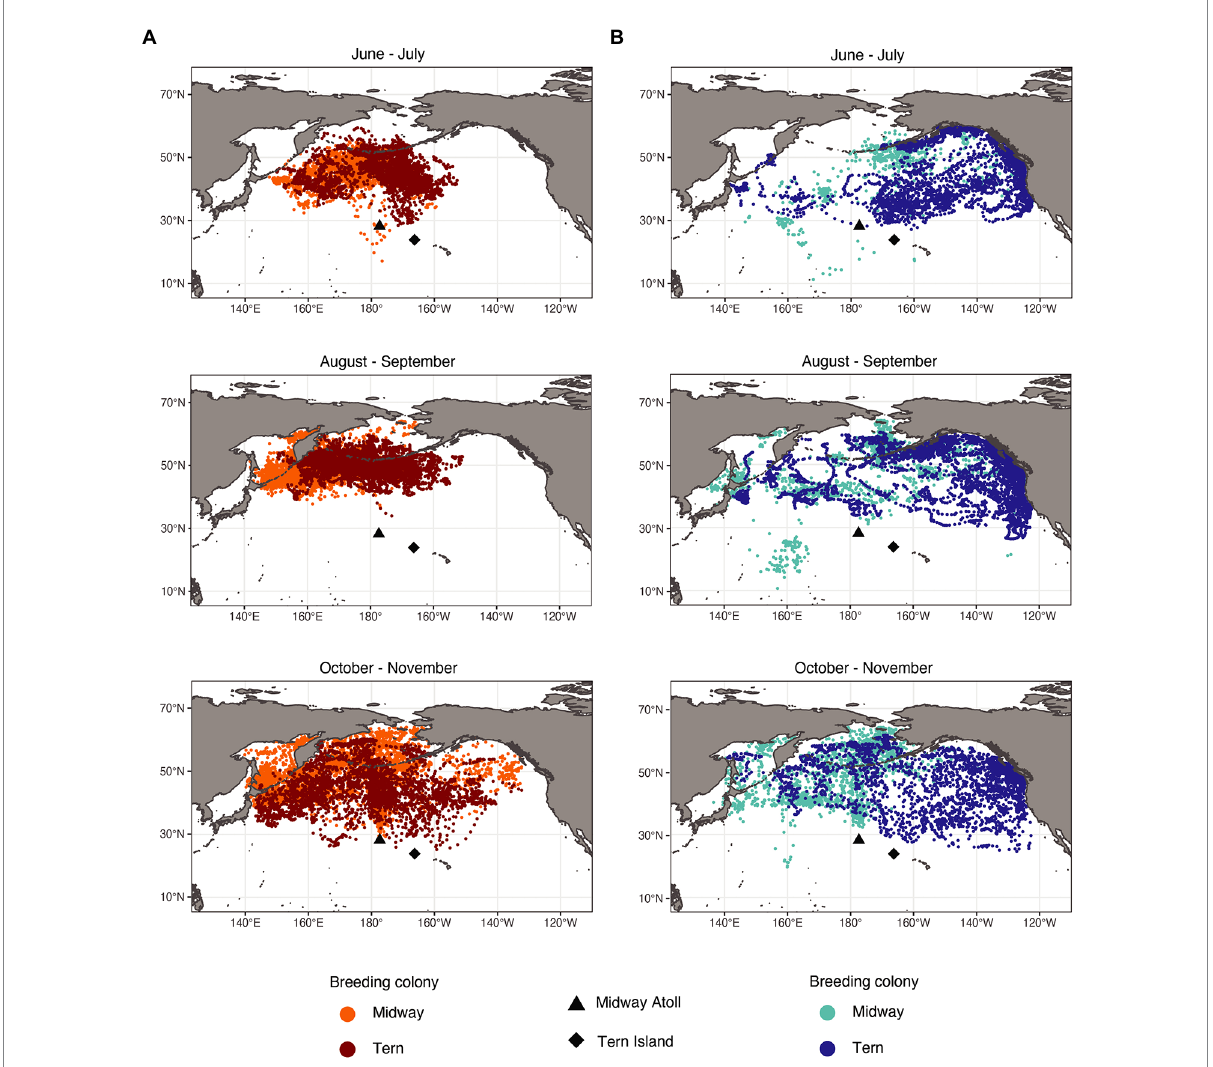
FIGURE 3 Laysan albatross (A) and black-footed albatross (B) post-breeding locations by month and breeding colony. Laysan and black-footed albatross breeding at Midway both left and returned to the breeding colony later than those breeding at Tern. As a result of departure and return dates, fewer Laysan albatross from Midway were tracked in June, and fewer Laysan albatross from Tern were tracked in November. Similarly, fewer black-footed albatross from Midway were tracked in June and July, and fewer black-footed albatross from Tern were tracked in